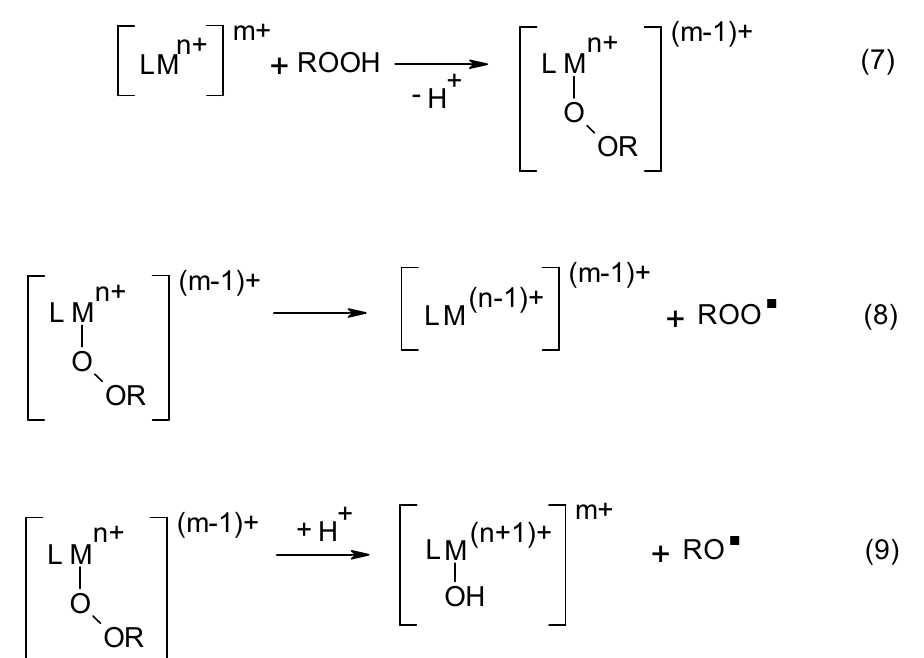
Scheme 2. Reactions showing the formation of peroxyl radicals (8) and alkoxy radicals (9) from a metal-alkylperoxyl intermediate obtained by reaction of the metal complex with an alkylhydroperoxide (7) [4].